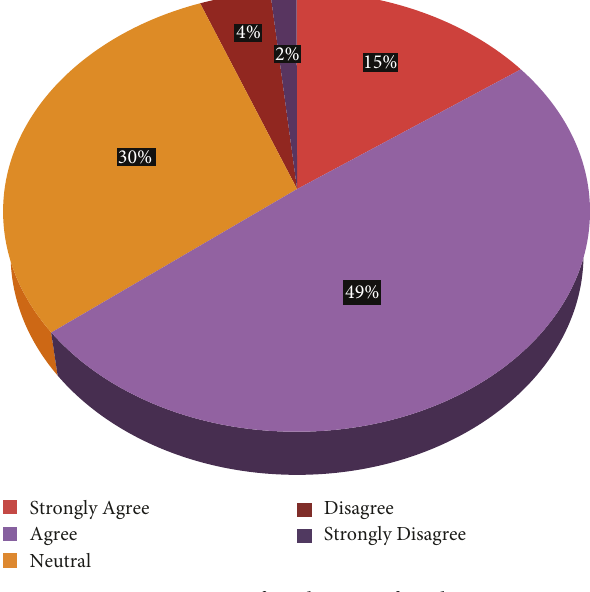
Figure 8: AI friends or my friends?